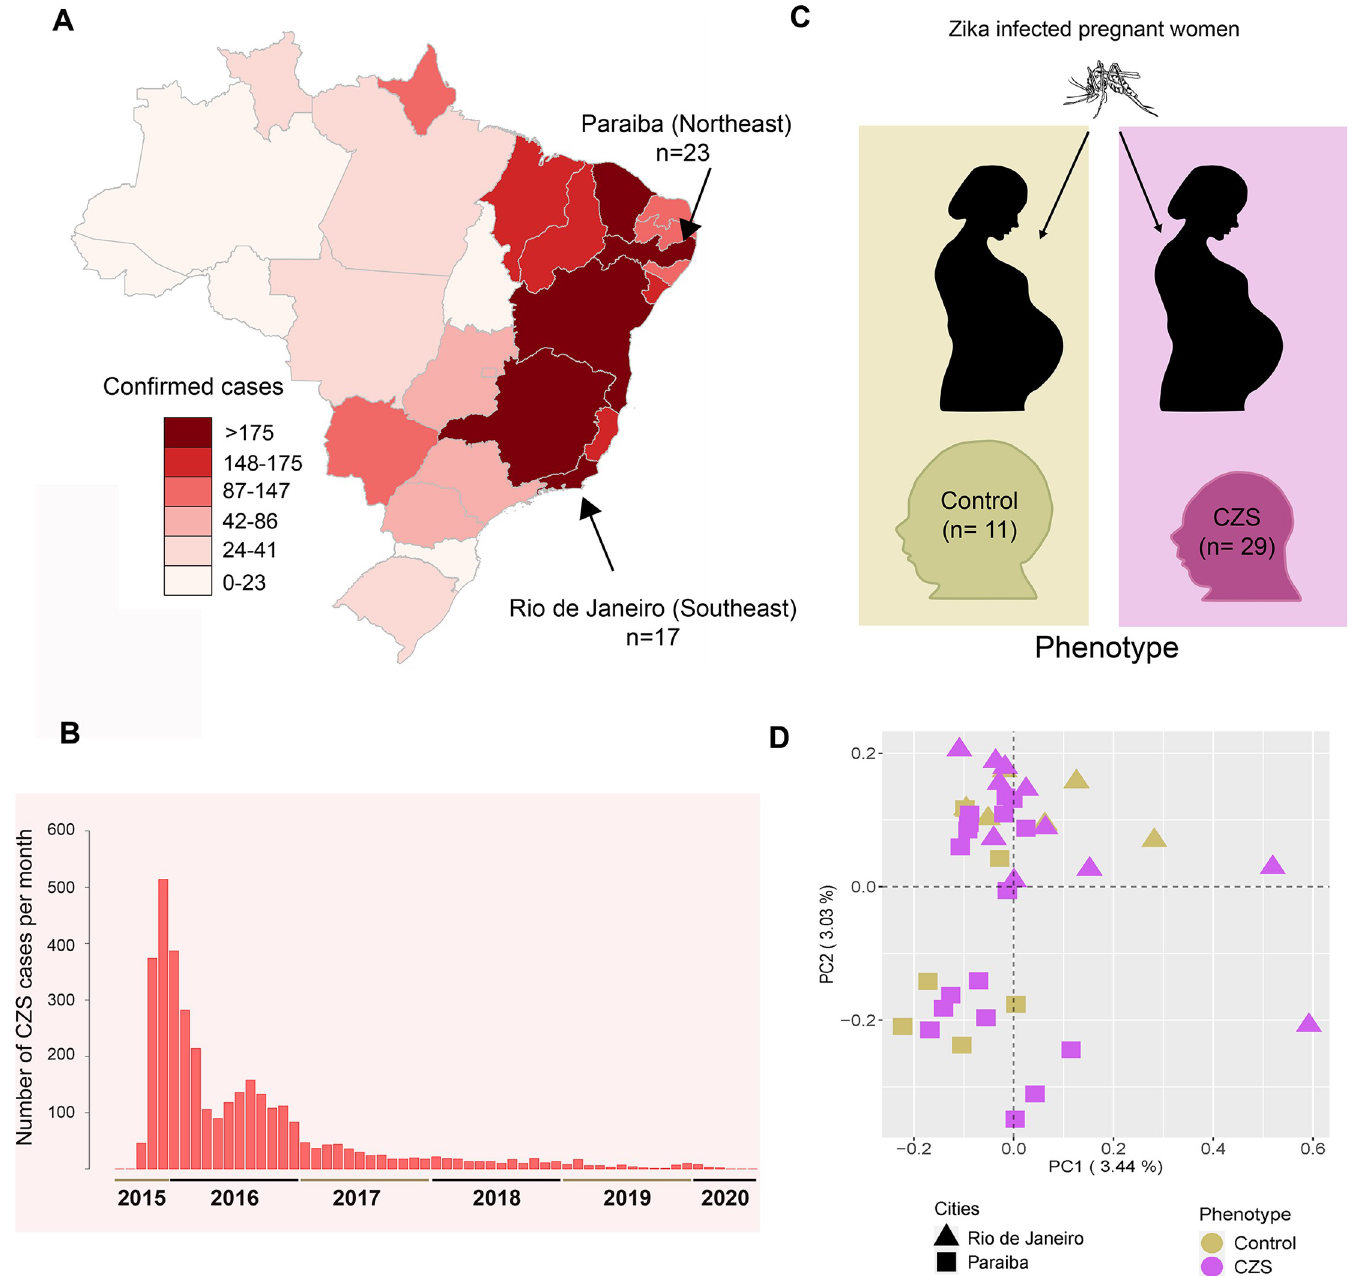
Fig 1. Geographical and temporal distribution, and Population Structure Analysis of Congenital Zika Syndrome (CZS) cohorts from Northeast and Southeast Brazil. (A) The map shows the accumulated distribution of CZS cases and the states in which the individuals were sampled (Coordenac¸ ã o-Geral de Vigilaˆncia das Arboviroses, 2020). In the Northeast, individuals were sampled in Paraiba state and in Southeast, individuals were sampled in Rio de Janeiro. (B) Bar plots show accumulated temporal distribution of CZS cases from the first outbreak in Brazil (2015) until present. (C) The cartoon shows the sampling design for cases and controls. Both types of individuals were sampled from ZIKV infected mothers. (D) Principal Component Analysis of the exome data of 40 Brazilian individuals with and without Congenital Zika Syndrome. Purple and yellow forms represent CZS and control individuals, respectively. Squares and circles represent Northeast (Paraiba) and Southeast (Rio de Janeiro) individuals,